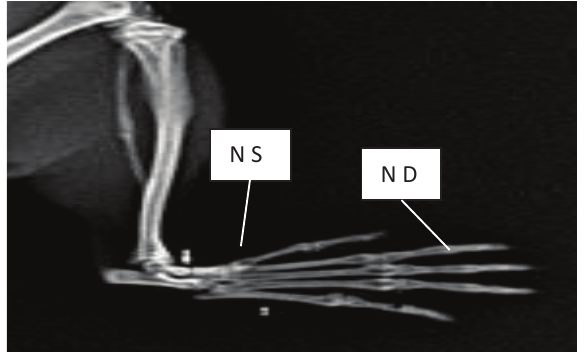
Fig-1: Group 1 Healthy control shows no swelling (NS) of hind paw and no deformity (ND) of interphalangeal joints.